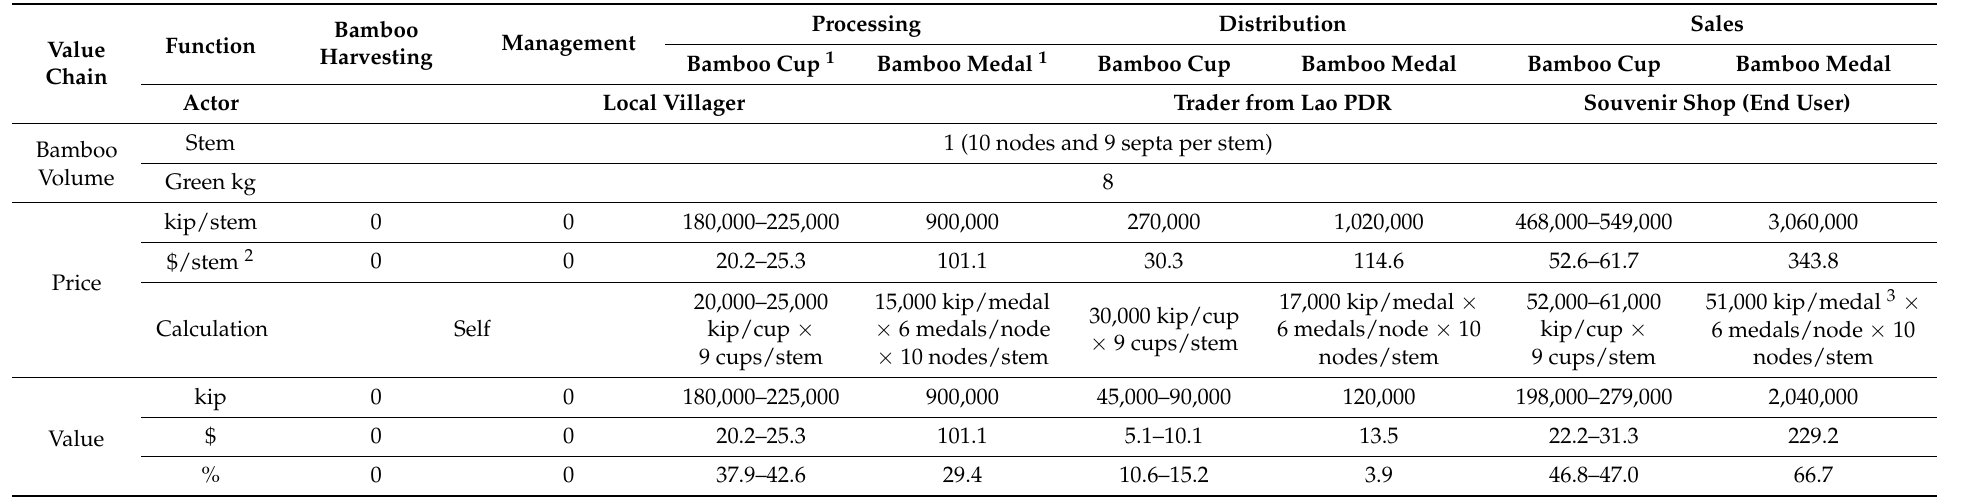
Table 5. New bamboo products value chain in Nongboua village, Sangthong